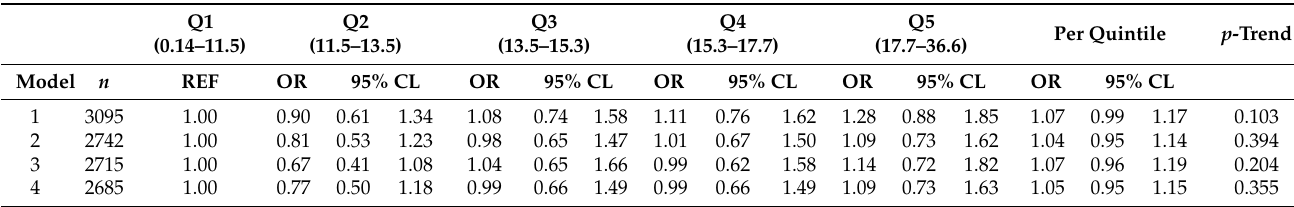
Table 2. Percent free sugar of total energy intake quintiles at three years and severe hepatic steatosis at 24 years in the ALSPAC cohort.